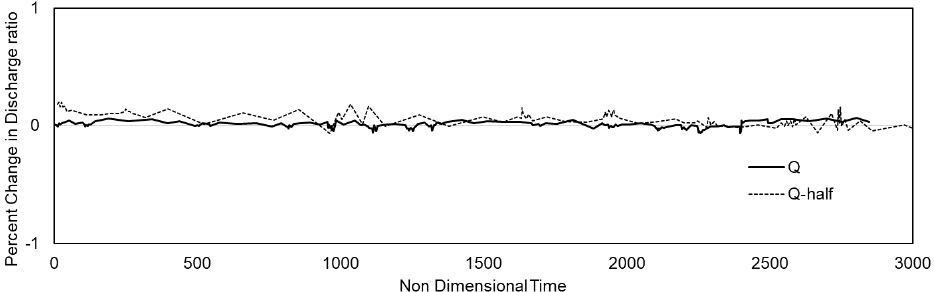
Figure 15. The percent change in discharge ratio at the bifurcation downstream of the Wax Lake delta apex. Q = the actual flow rates of the WLD from 1998–2012, and Q-half = the flow rates from 1998–2012 are reduced by 50%.